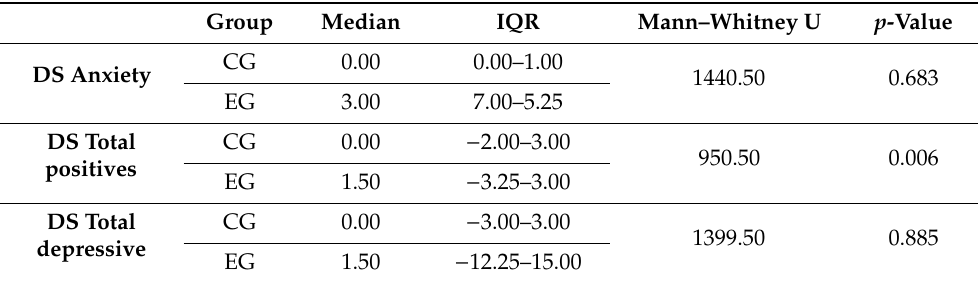
Table 4. Comparison of di ff erential scores of psychological variables according to the type of